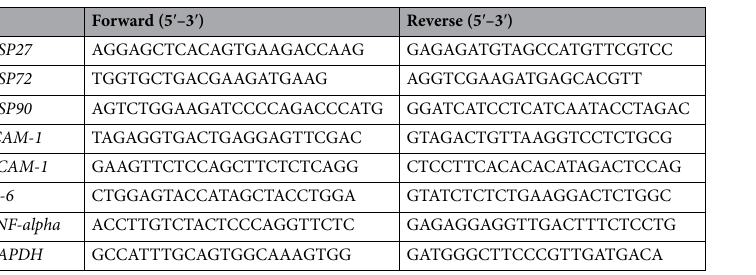
Table 1. Oligonucleotide sequences for real-time PCR amplification.